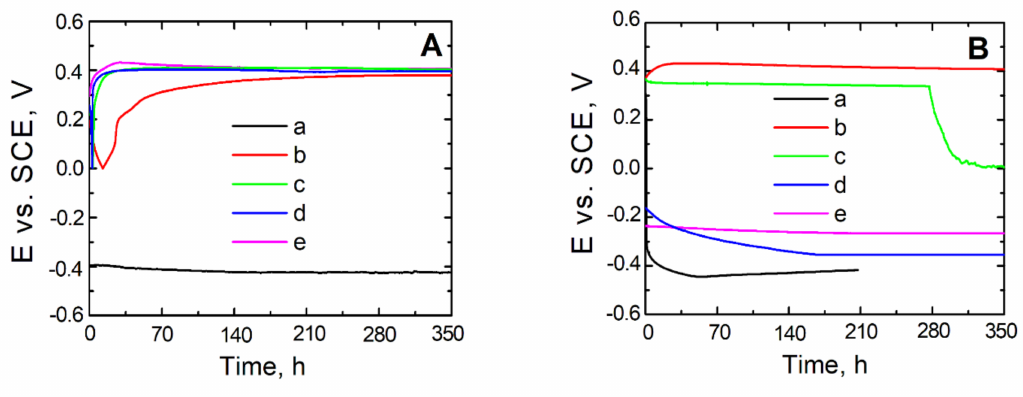
Figure 6. Potential measurement in open circuit potential OCP from exposure time in solution: 0.5 mol dm − 3 Na 2 SO 4 mol dm − 3 pH = 2 ( A ) and 0.5 mol dm − 3 Na 2 SO 4 + 0.5 mol dm − 3 NaCl pH = 2 ( B ) for steel X20Cr13 uncovered (a) and covered with coatings VTMS/EtOH: CH 3 COOH (b), LiClO 4 (c), H 2 SO 4 (d), NH 3 (e).